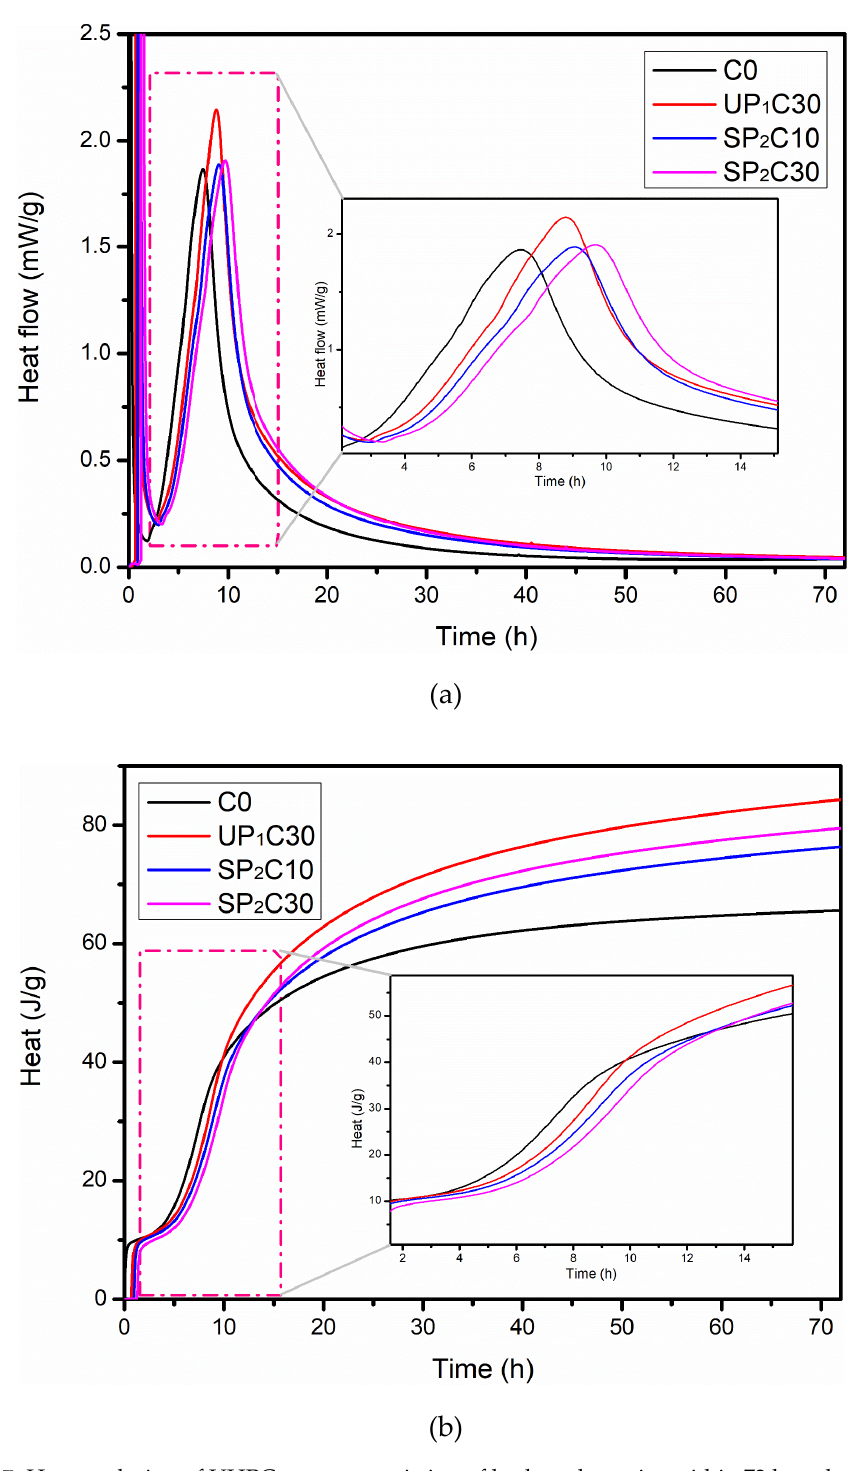
Figure 7. Heat evolution of UHPC system consisting of hydrated pumice within 72 h under several typical mix design conditions: ( a ) heat flow; ( b ) total heat.